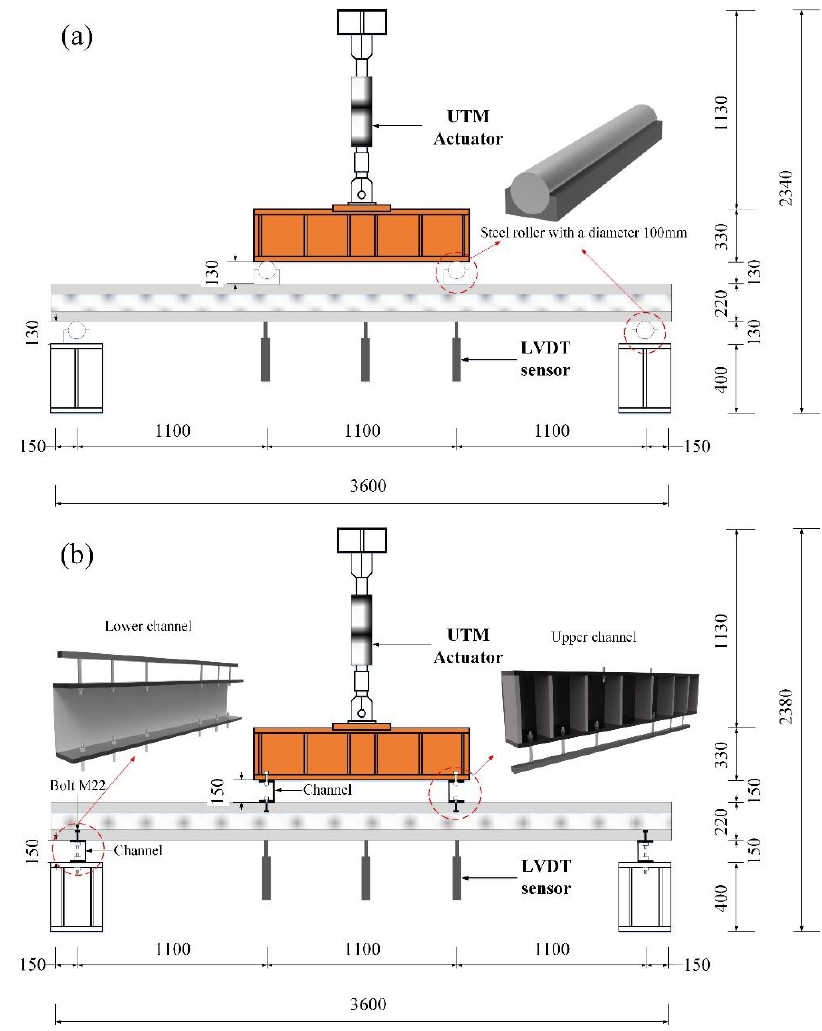
Figure 5. Experimental test-setup under ( a ) positive loading and ( b ) negative